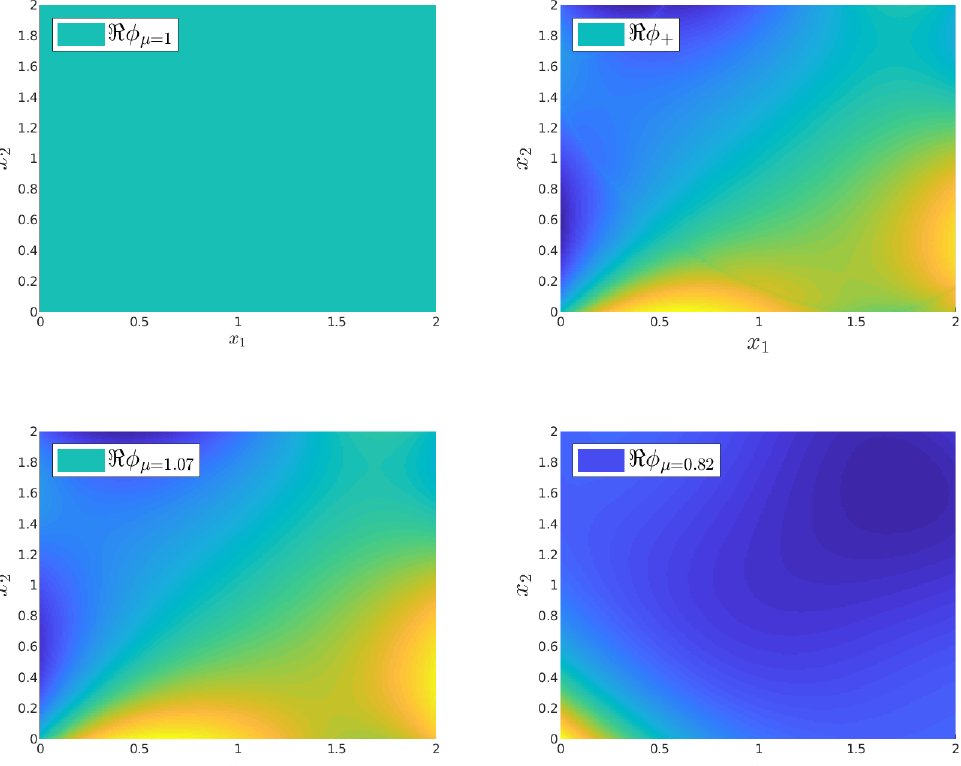
Figure 3. Eigenfunctions of the Koopman operator: ( top left ) trivial eigenfunction with µ = 1; ( top right ) constructed eigenfunction φ + ; ( bottom left ) first eigenfunction for constructing φ + ; ( bottom right ) second eigenfunction for constructing φ +